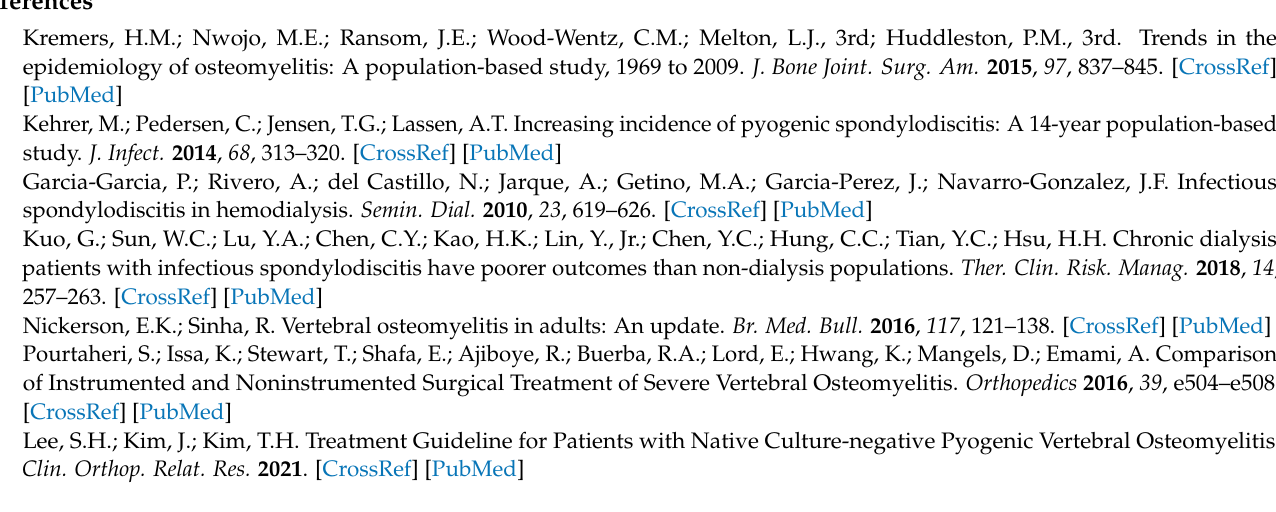
univariable analysis; Table S2: Comparison of baseline patient characteristics of the two surgical cohorts before and after propensity score matching; Table S3: Comparison of infection profiles of the two surgical cohorts before and after propensity score matching; Table S4: Comparison of Surgical Table S5: Causative organisms of the three